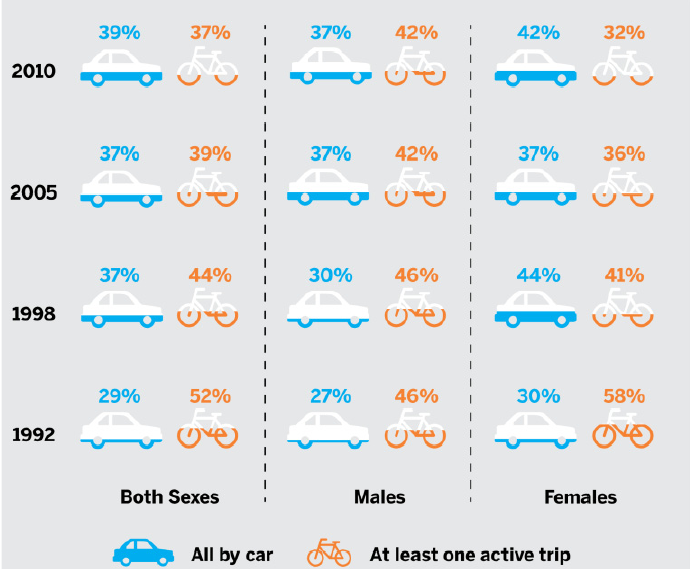
Figure 3. The percentage of 15- to 17-year-olds in Canada who take all their daily trips by car and who take at least one daily trip using active transportation between 1992 and 2010